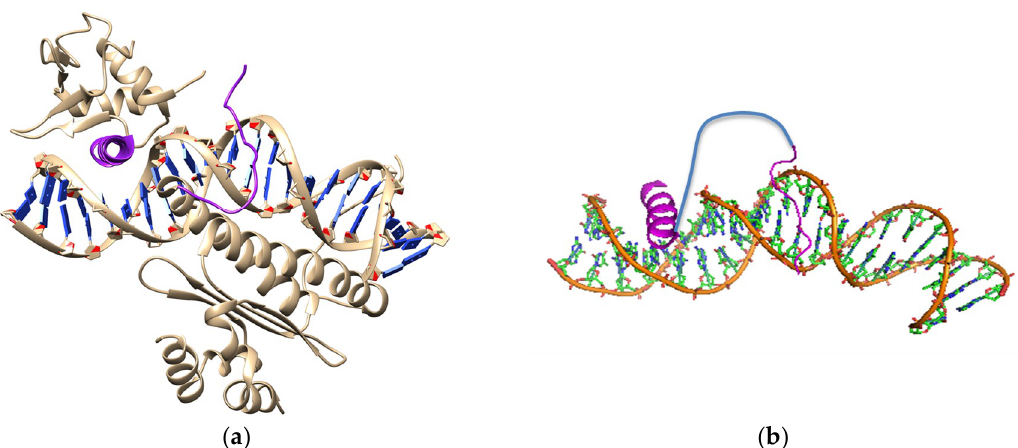
7 of 15 Figure 2. Cartoon diagram of structure of ( a ) Synthetic Transcription Factor (STF) mimicking the λ- Cro; Bright blue part is the helical part of the construct, while the linker regions are represented in light blue and red colours. ( b ) STF mimicking the λ-Cro but carrying mammalian NLS, CPP, and Activation Domain (AD). Orange chain denotes the linker. Another attempt was made to control the expression of c-FOS gene in a RAS mutant cell line (93). The aberrantly activated EGFR-RAS-MAP kinase pathway bearing an oncogenic mutant RAS protein is the driver of about 20% of cancers [108]. One of the important end-points of the RAS-MAP (Mitogen-activated protein kinase) kinase pathway is the ETS (E-26 transformation-specific family of proteins) family transcription factor, ELK-1. Gene regulatory action of ELK-1 on the c-FOS promoter occurs upon simultaneous and cooperative binding of the serum response factor (SRF) to adjacent sites of the c-FOS promoter [109,110]. A modular approach was adopted for the design of this STF. An Aib-containing helically constrained peptide encompassing the DNA-interacting segments of ELK-1 (helix), and the proximal minor groove binding part of SRF was linked by a suitable linker sequence (Figure 3). The designed peptide showed good affinity and single basepair discrimination